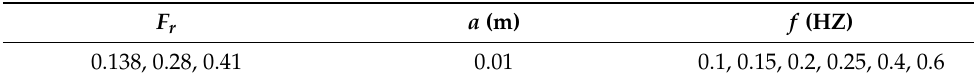
Table 8. Calculation cases of pure heave motion.